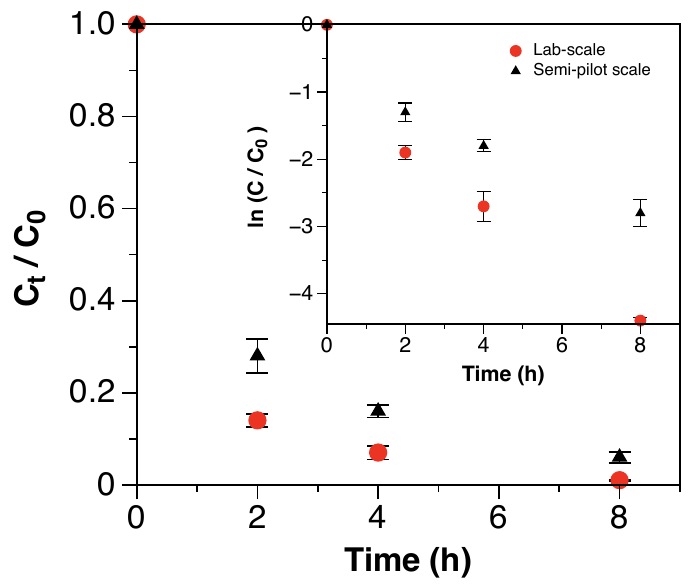
Figure 3. Decrease in total PFAAs concentration during the electrochemical treatment of a synthetic still bottoms solution with 50 mA/cm 2 in laboratory and semi-pilot scale systems. Inset shows the pseudo-first-order removal rate for PFAAs for both system